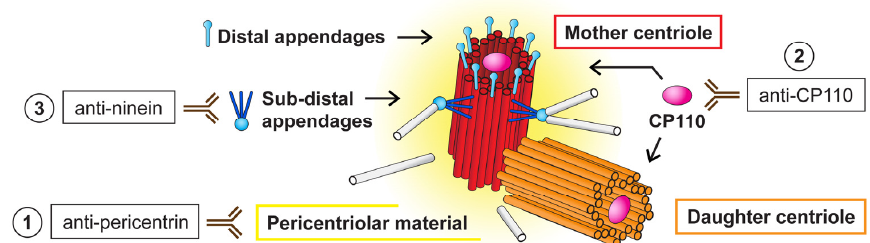
Figure 2. Schematic overview of the different centriolar structures and centrosome-specific antibodies used in this study. The centrosome is a microtubule organizing center (MTOC) composed of two centrioles—older mother centriole (red) and younger daughter centriole (orange). These two centrioles differ structurally [40–42]. The mother centriole has distal and subdistal appendages (blue) [43], which promote membrane docking during cilia initiation [44] and microtubule anchoring [45,46], respectively. Both centrioles are surrounded by pericentriolar material (yellow). Binding of the antibodies used in the study to distinguish specific centrosomal parts is depicted: (1) anti-pericentrin antibody is suitable to detect the whole centrosome, (2) anti-CP110 antibody recognizes distal ends of individual centrioles, and (3) anti-ninein is specific for subdistal appendages of the mother centriole.